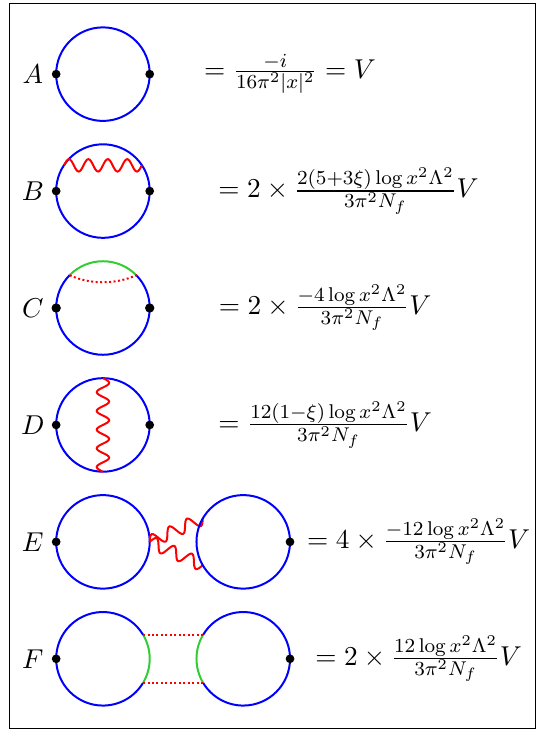
Table 13 . ( N = 1 SQED) Results for individual Feynman graphs appearing in the 2-point corre- lation function for the scalar-bilinear